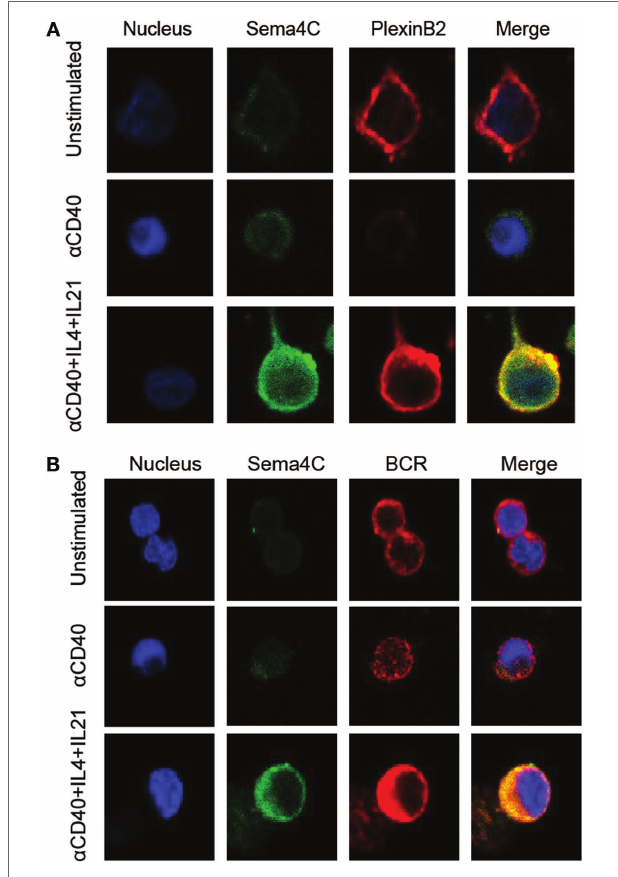
FigUre 6 | human sema4c colocalizes with Plexin-B2 and Bcr . Human B-cells isolated from tonsil were stimulated with anti-CD40 in the presence or absence of IL-4 and IL-21 for 5 days in slide chamber. (a) Representative images of cells stained with anti-Sema4C antibodies (green), anti-Plexin-B2 antibodies (red), and a nuclear stain (Hoechst 33342, blue). Upper panel: unstimulated tonsillar B-cells showing constitutive Plexin-B2 staining but minimal Sema4C; middle panel: anti-CD40 antibodies for 5 days indicating minimal Sema4C expression but no Plexin-B2; and lower panel: anti-CD40 antibodies + IL-4 + IL-21 indicating optimal Sema4C expression and organization into a synapse-like structure colocalizing with Plexin-B2. (B) Representative image of cells stained with anti-Sema4C antibodies (green), anti-BCR antibodies (red), and a nuclear stain (Hoechst 33342, blue). Upper panel: unstimulated tonsillar B-cells showing constitutive BCR staining but minimal Sema4C expression; middle panel: anti-CD40 antibodies for 5 days indicating minimal Sema4C expression; and lower panel: anti-CD40 antibodies + IL-4 + IL-21 indicating optimal Sema4C expression and organization into a synapse-like structure colocalizing with BCR.